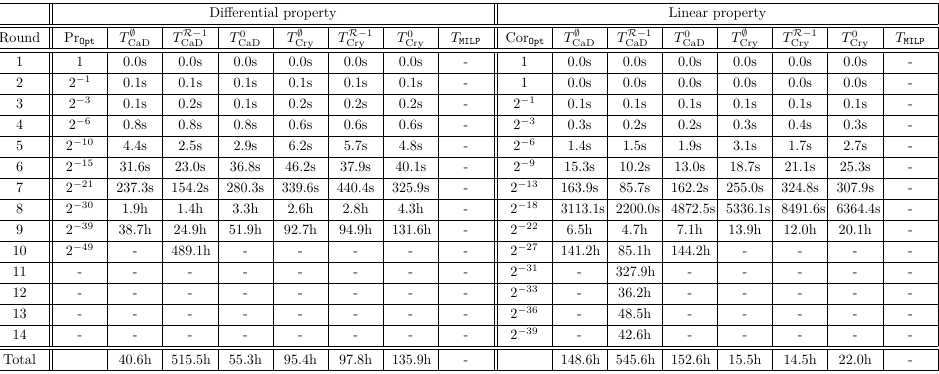
Table 20: Experimental results of SPECK96 .